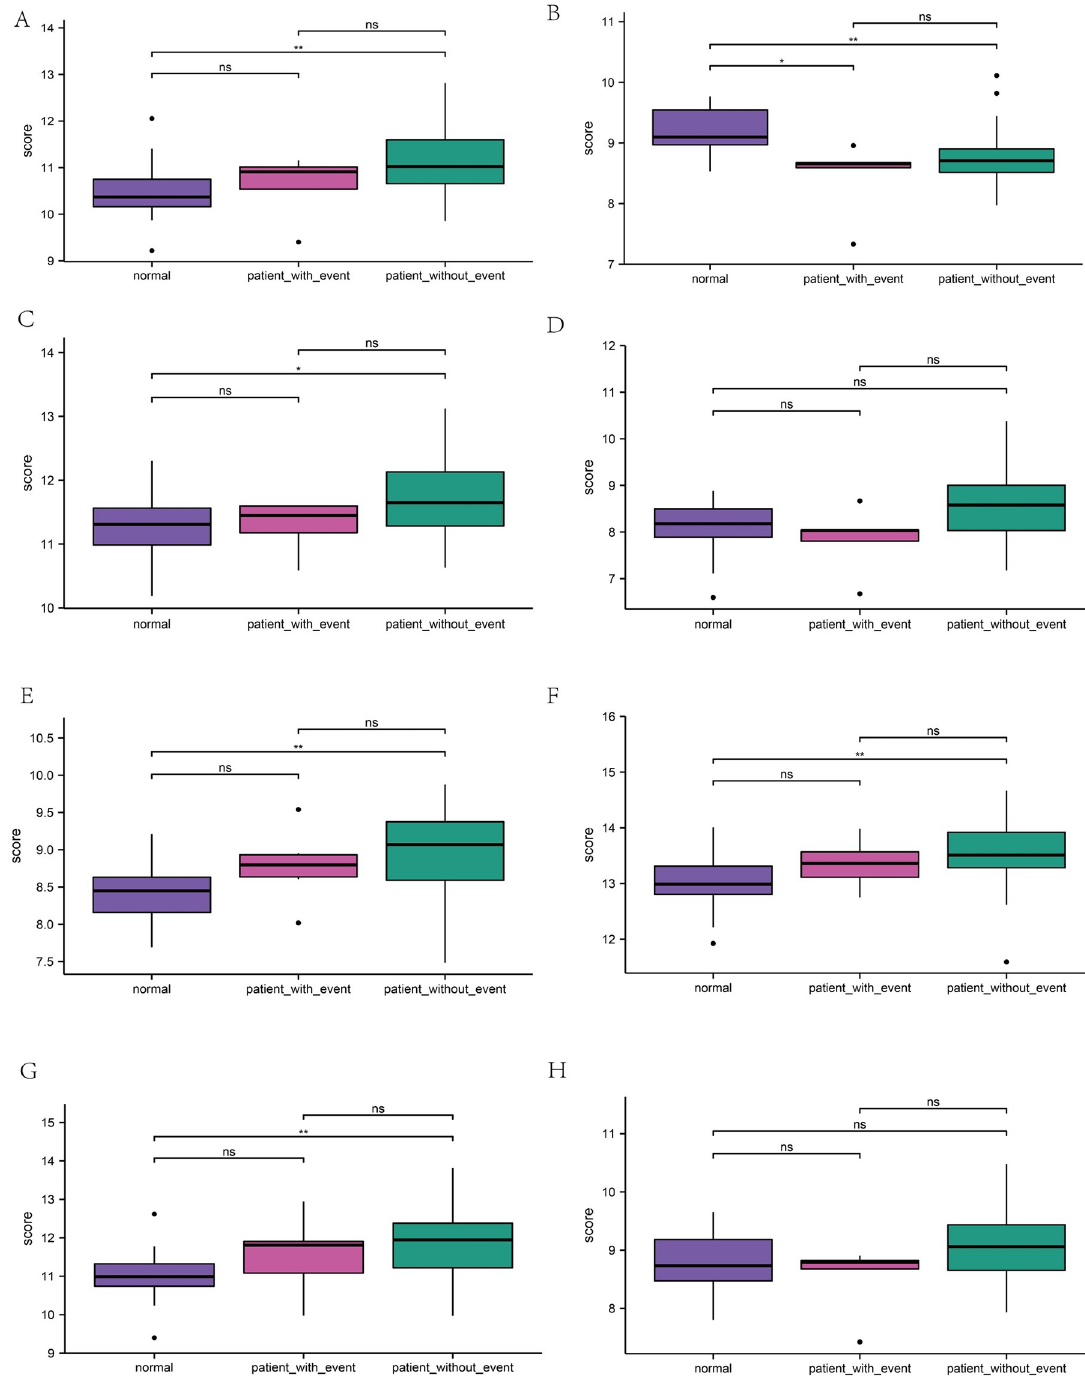
Fig 4. Box plots for group comparisons. Verification of the eight immune system-specific hub genes that are expressed. ��� : p < 0.001, �� : p < 0.01, � : p < 0.05, ns: no significant difference. A significant upregulation of five genes occurs in MI samples compared to standard samples. A. Group comparisons of AQP9 . B. Group comparisons of CCL4 . C. Group comparisons of FPR1 . D. Group comparisons of IL1B . E. Group comparisons of IL1RN . F. Group comparisons of S100A9 . G. Group comparisons of S100A12 . H. Group comparisons of TREM1